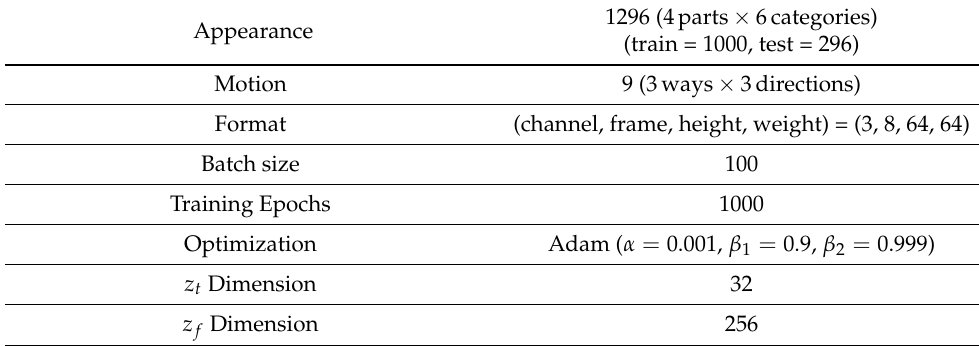
Figure 5. Example of reconstruction on the Sprites dataset. The top, middle, and bottom rows denote the input video and results using the DSVAE and proposed methods, respectively. Table 1. Learning condition for the Sprites dataset.